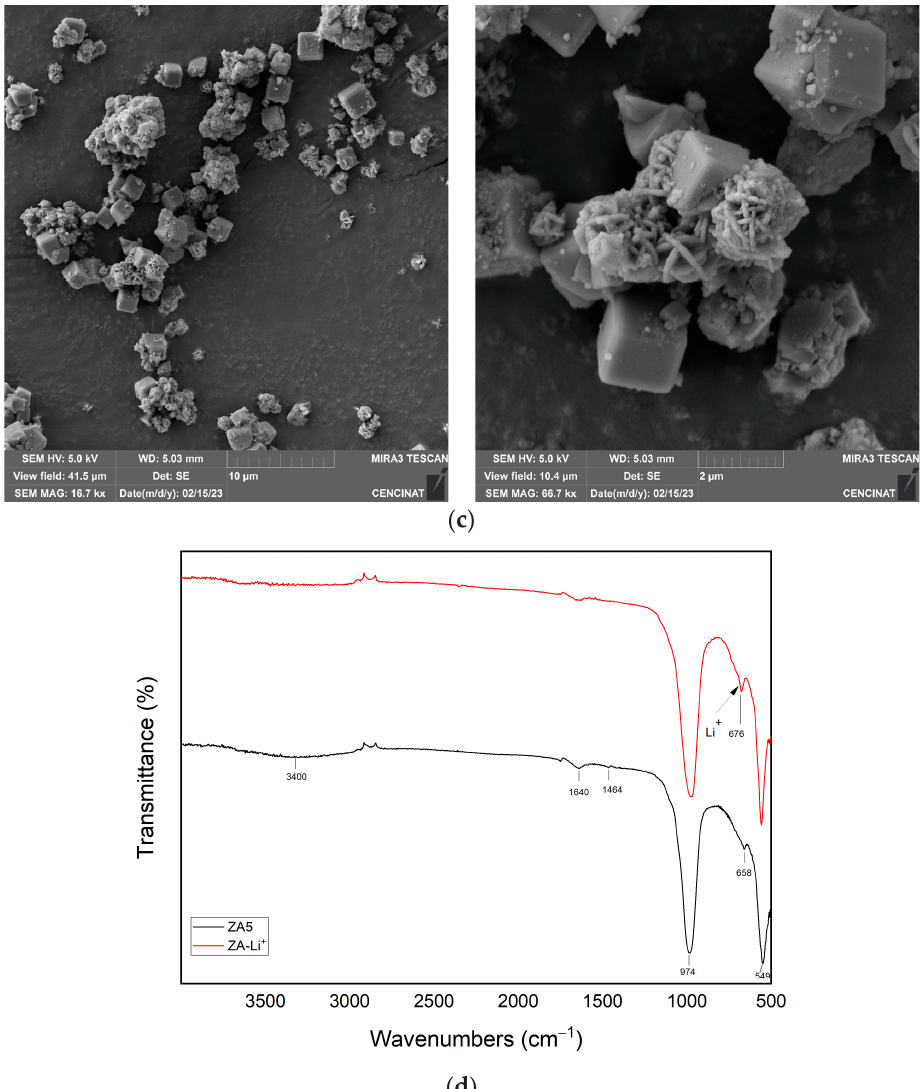
Figure 10. XRD patterns of the synthesized zeolite ZA5 and lithium hydroxide nanoparticles ZA-Li + ( a ), * sodalite and ◦ LTA. SEM micrographs of ( b ) ZA5 and ( c ) ZA-Li + . FTIR spectrum of ZA5 and ZA-Li + ( d ).